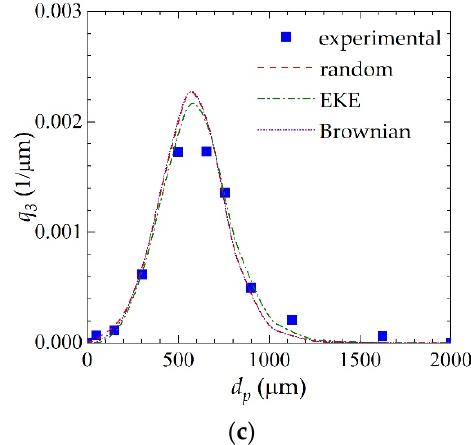
Figure 7. Measured and simulated mass density distribution q 3 for the test without tenside: ( a ) t = 0 min; ( b ) t = 10 min; ( c ) t = 20 min.